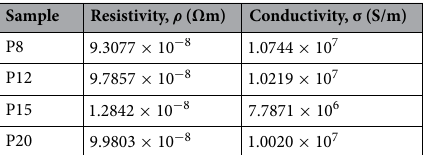
Table 5. Resistivity and conductivity of all samples.